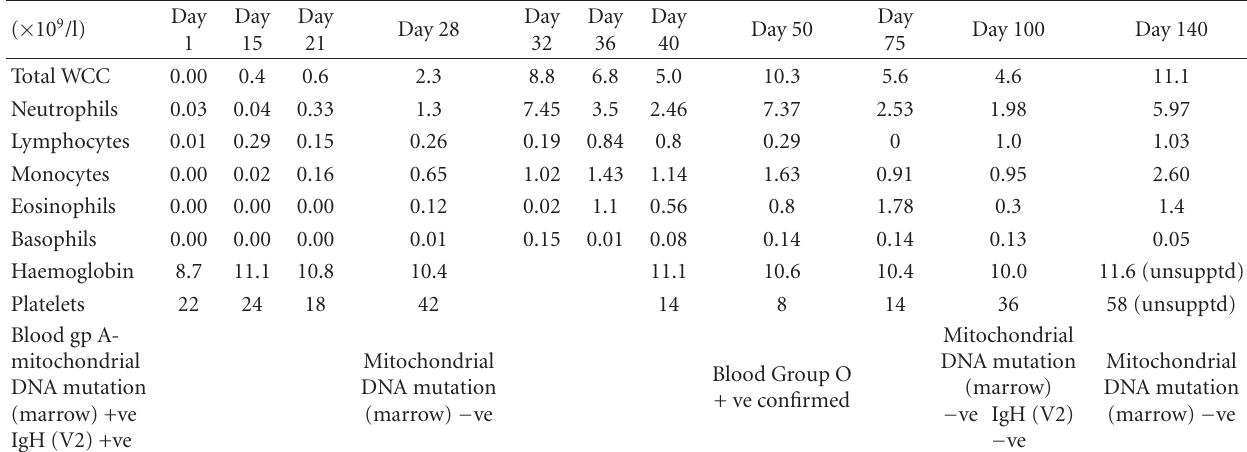
Table 2: Pattern of haematological engraftment. Cell counts and tracking data for the post transplant period. A relative monocytosis and eosinophillia has persisted throughout the engraftment period. Marrow at day 28, 100 and 140 demonstrates molecular remission using MRD